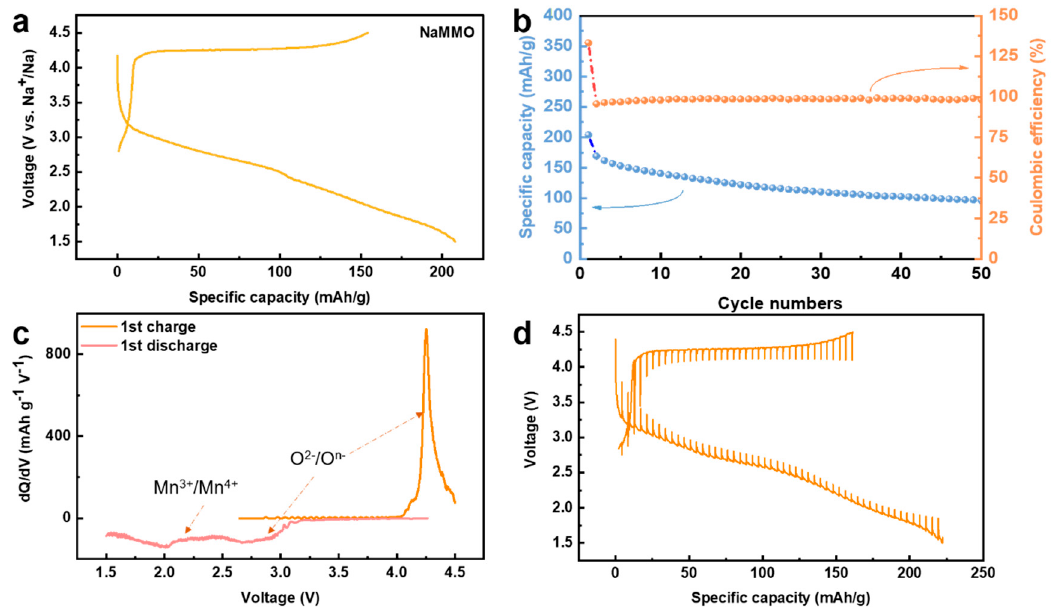
Figure 3. ( a ) Galvanostatic charge / discharge profiles of NaMMO for the 1st cycle at C / 20 between 4.5 and 1.5 V vs. Na + / Na. ( b ) Cycle performance at C / 20 between 4.5 and 1.5 V. ( c ) dQ / dV plots for the 1st cycle. ( d ) The GITT curves for the 1st cycle.